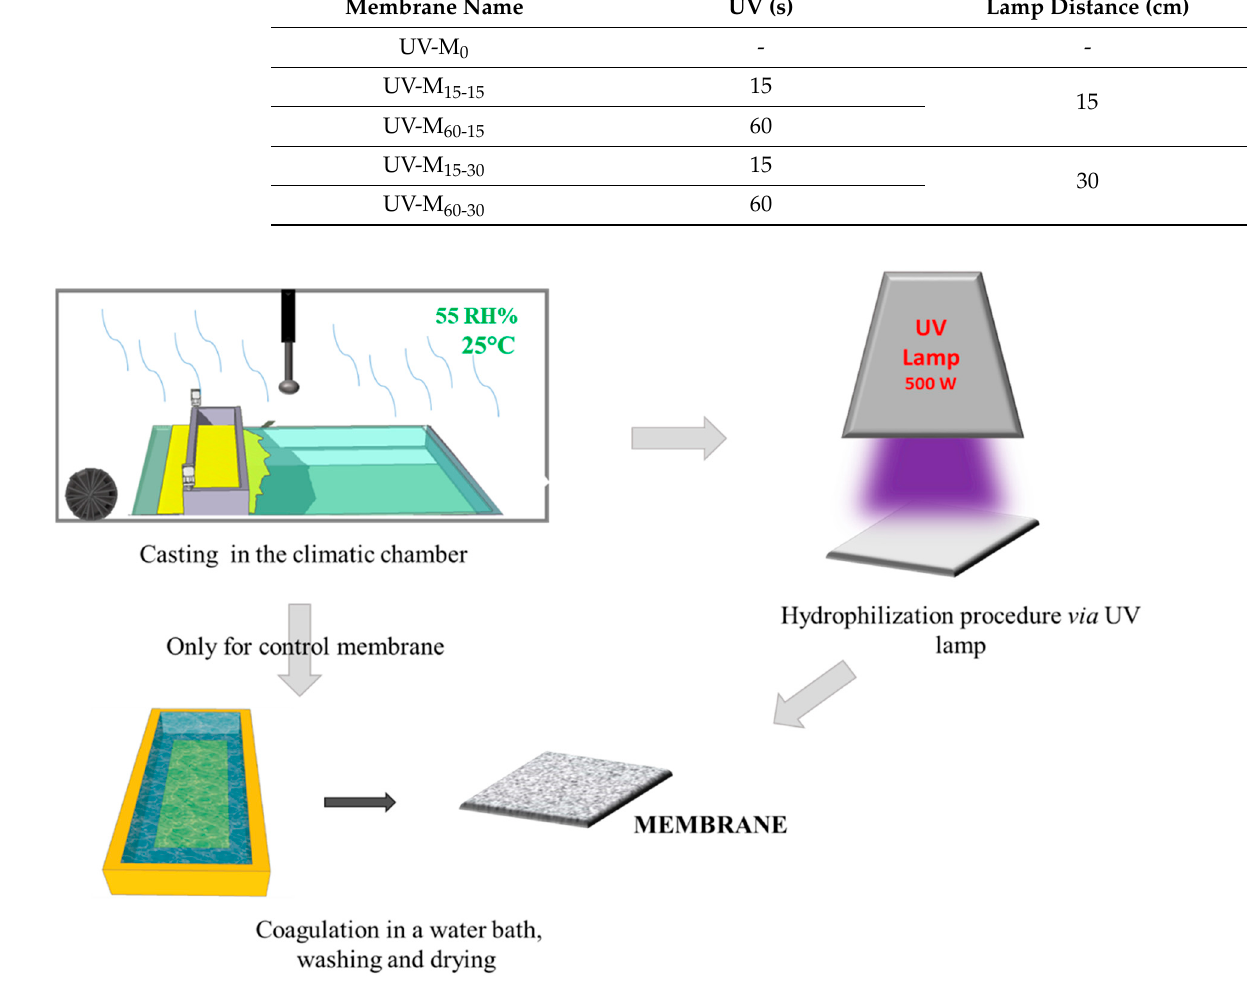
Figure 1. A simplified scheme of the membrane preparation .